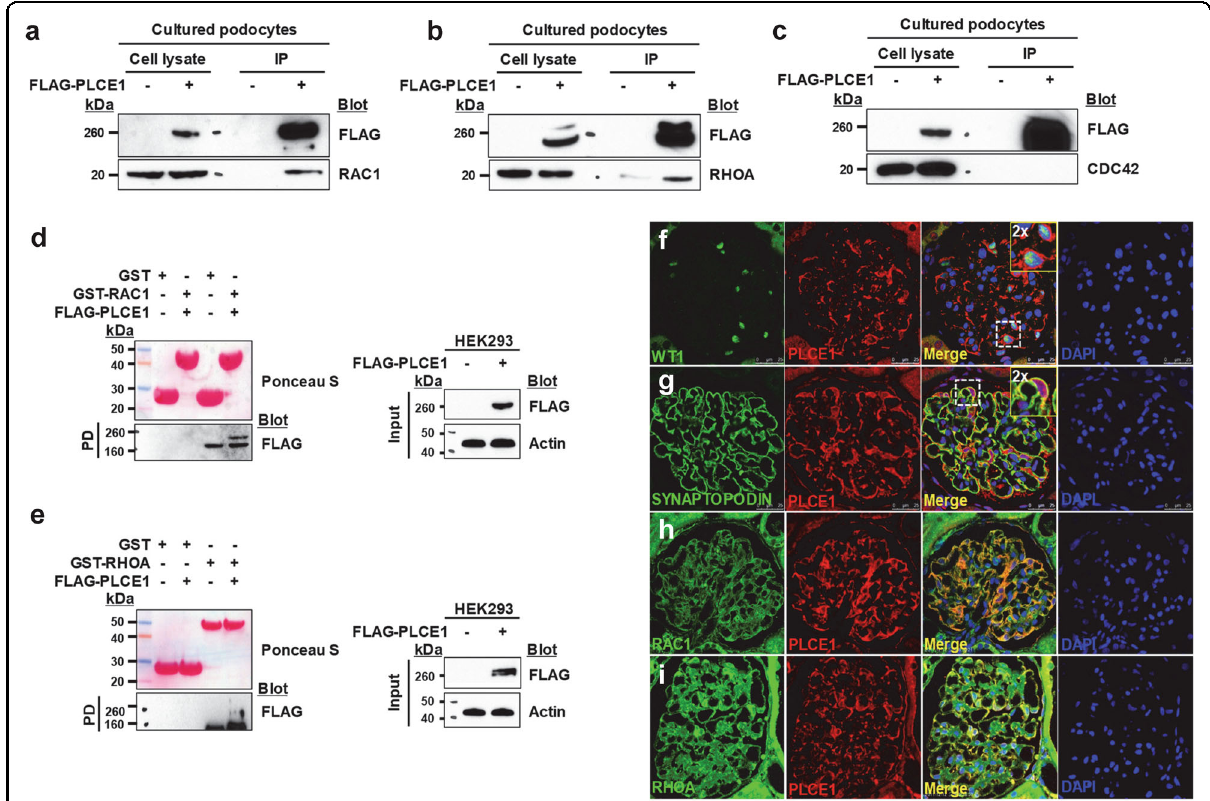
Fig. 1 PLCE1 interacts with Rac1 and RhoA. a – c Immunoprecipitation of PLCE1 with Rho GTPase, Rac1 ( a ), RhoA ( b ), and Cdc42 ( c ) in cultured podocytes. Immunoblotting showed that PLCE1 interacts with Rac1 and RhoA but not with Cdc42. d – e FLAG-PLCE1 expressed in HEK293 cells was precipitated by GST- Rac1 ( d ) and GST-RhoA ( e ). Ponceau red staining at the top shows the GST proteins used. f – i Costaining of PLCE1 with WT1 ( f ), SYNAPTOPODIN ( g ), Rac1 ( h ) and RhoA ( i ) using immuno fl uorescence in adult rat glomeruli. PLCE1 colocalized with Rac1 and RhoA in podocyte cell bodies. Immunoprecipitation (IP) and pulldown (PD) experiments are representative of more than three